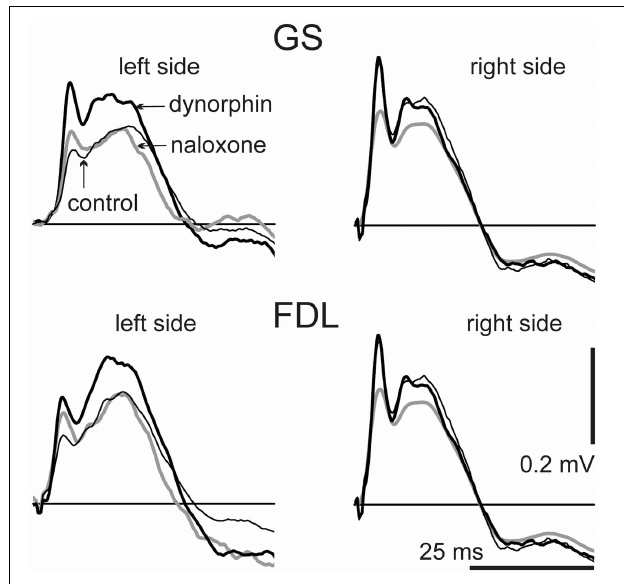
FIGURE 1 | Dynamics of changes in the field potentials (FPs) recorded bilaterally during consecutive stimulation of GS and FDL nerves in both hind limbs. The averaged FPs ( n = 10) are shown: before injections ( control , thin black lines); within an interval 10–15min after dynorphin B injection ( dynorphin , thick black lines), and within an interval 10–15min after naloxone injection ( naloxone , gray lines). The single FPs serving for the averaging procedure were also used for quantitative assessment of the changes ( Figures 2 , 3 ; Tables 1 , 2 ). For this purpose, there were defined areas of the initial positive components of single FPs (upward deflections of the signals lying above the straight lines of zero potential). Further quantitative treatments of the data for this experiment are presented under experiment N8 in Figures 2 , 3 and in Tables 1 , 2